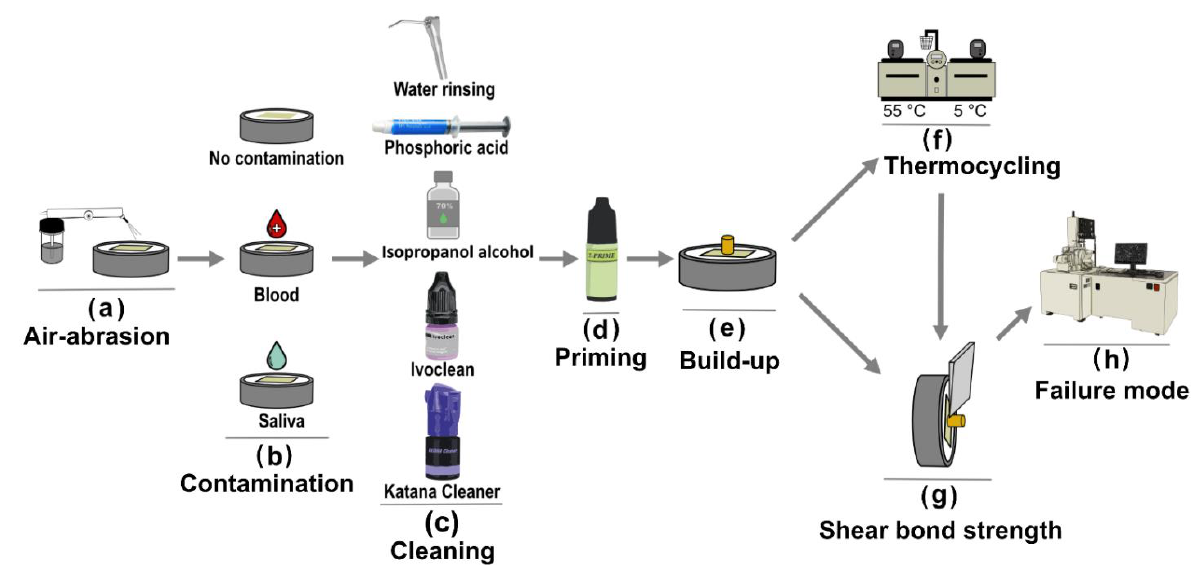
Figure 1. Schematic illustration of the study design showing variables employed in specimens’ preparation. ( a ) Air-abrasion of zirconia ceramic employed to all specimens. ( b ) Contamination: no contamination or contaminated specimens (blood or saliva). ( c ) Cleaning (decontamination) methods (water rinsing ‘no cleaner’, 38% phosphoric acid etching, 70% isopropanol alcohol, Ivoclean (Ivoclar Vivadent) or Katana Cleaner (Kuraray Noritake)). ( d ) Zirconia priming. ( e ) Resin cement build-up. ( f ) Thermocycling (10 k TC). ( g ) SBS testing. ( h ) Failure mode evaluation using scanning electron microscope (SEM).